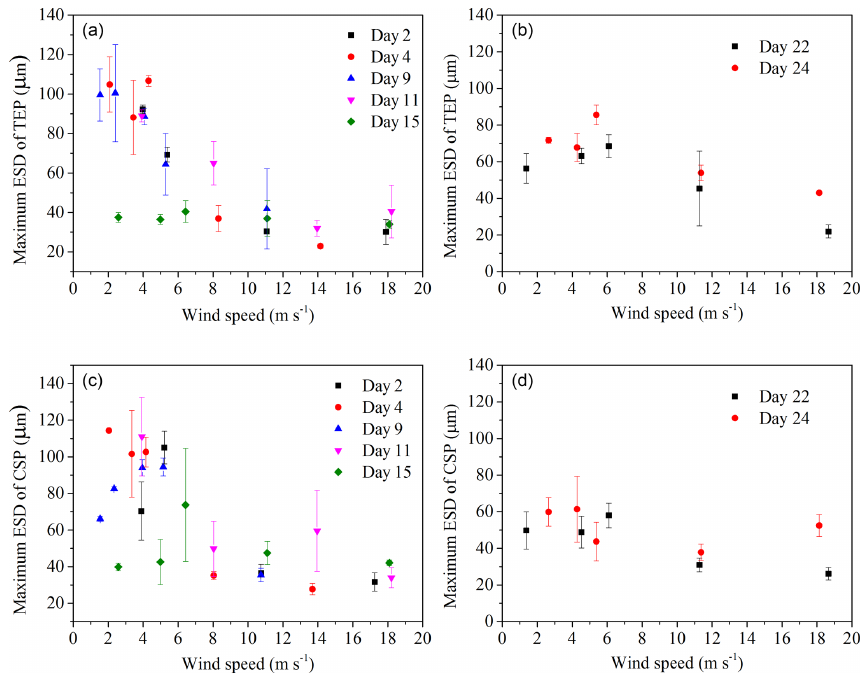
Figure 6. Maximum size (ESD) of gel particles in the SML; (a) and (c) before addition of E. huxleyi ; (b) and (d) after addition of E. huxleyi .